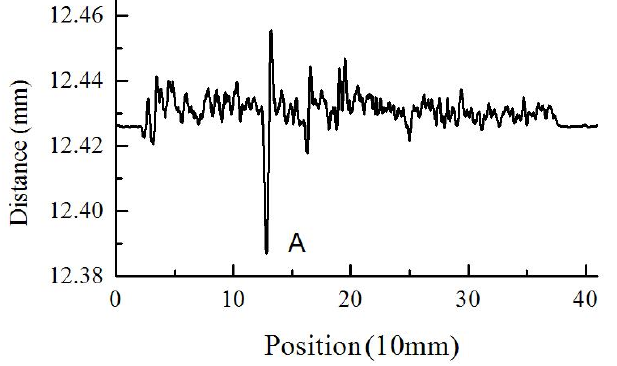
Figure 8. Variation in the measured distance with WP.